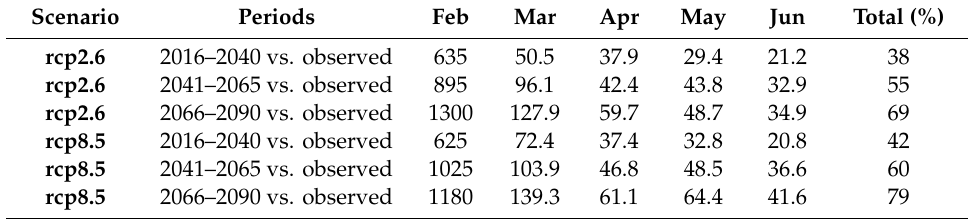
Table 6. Change values of the irrigation water requirement (IR) of winter wheat under scenarios rcp2.6